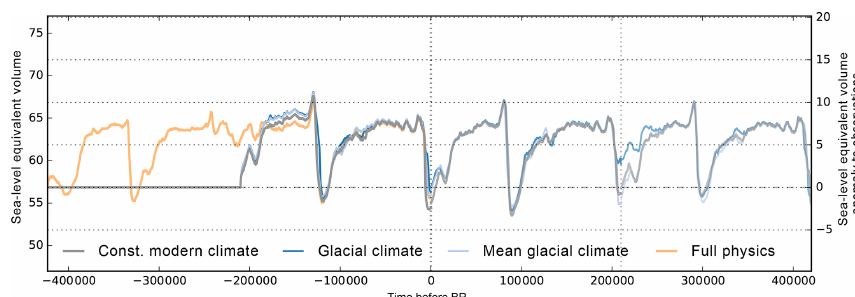
Figure 1. Ice volume above flotation for simulations over the last glacial cycles with identical parameter settings but based on different spin- up procedures. The initialization method as used in the reference simulation is depicted in grey, while the orange line indicates a simulation over the last four glacial cycles. The simulations with identical initial geometry are continued into the future for repeated climate forcing of the last two glacial cycles (indicated by vertical dotted